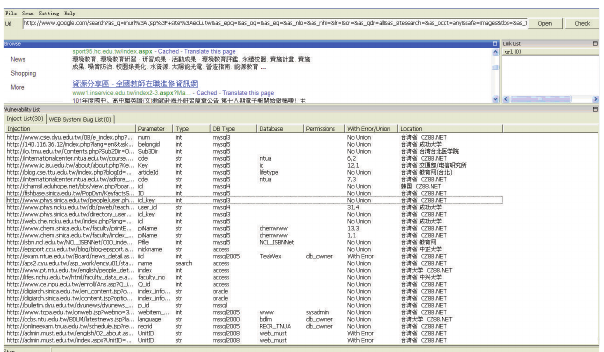
Figure 13: Possibility of leaking in databases.